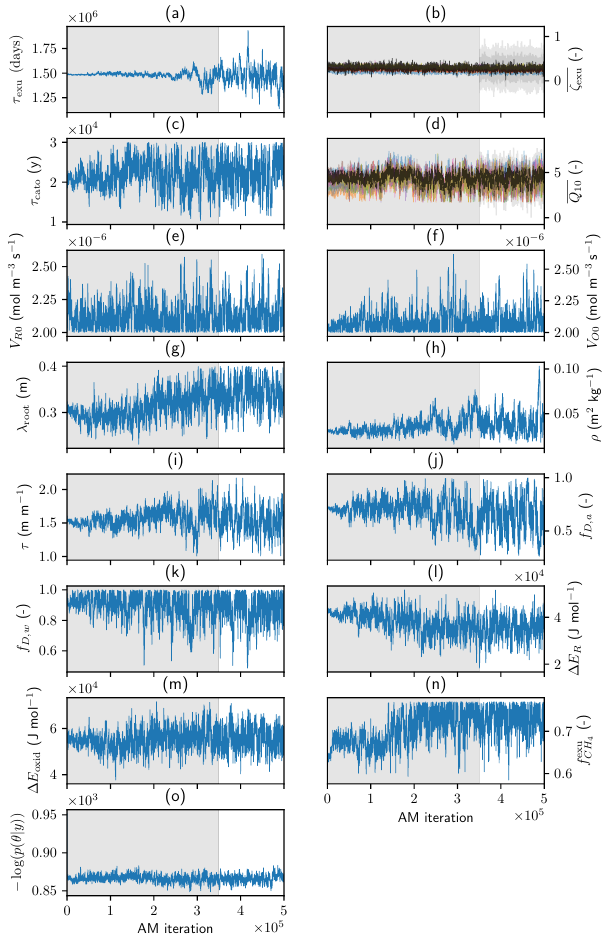
Figure 3. MCMC chains showing a thinned sample of the half mil- lion values in the chain. The first 70% was discarded for the analy- ses as a warm up and is grayed out in the figures. The hierarchical parameters in panels (b) and (d) show the mean value in the middle as a black mass, and the colorful surroundings are the values of the parameters for the individual years. Panel (o) shows the value of the objective